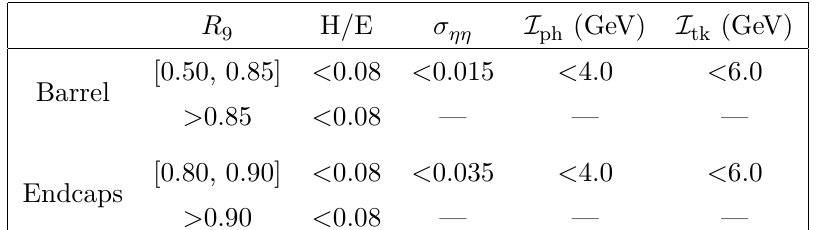
Table 1 . Schema of the photon preselection requirements. The requirements depend both on whether a photon is in the barrel or endcap, and on its R